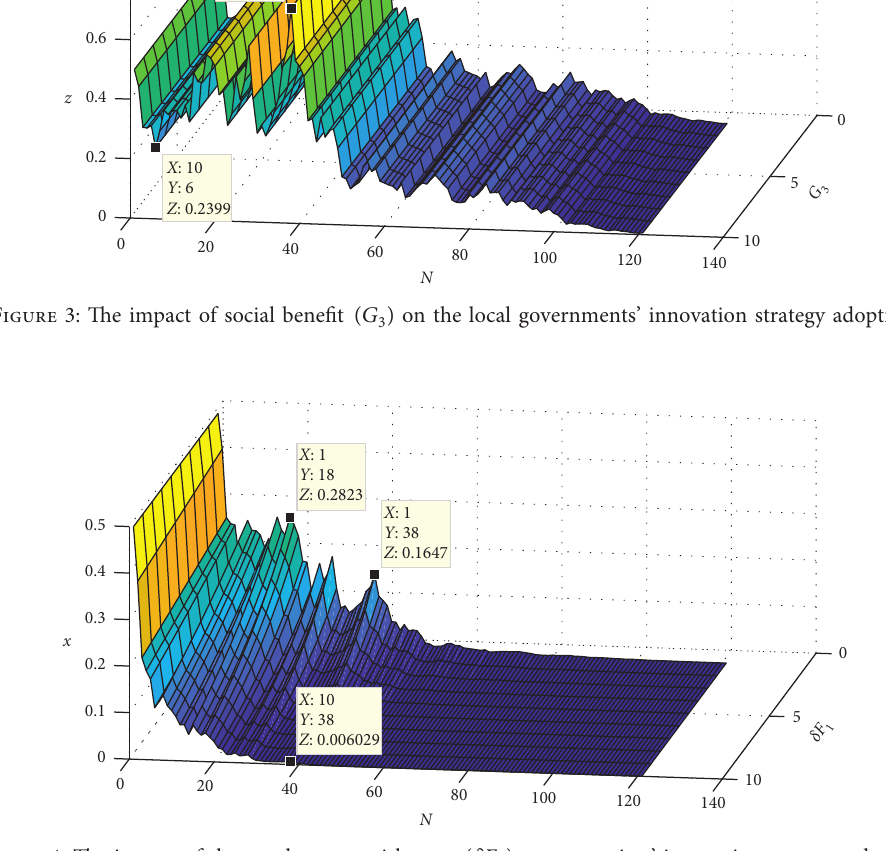
) on enterprises’ innovation strategy 1